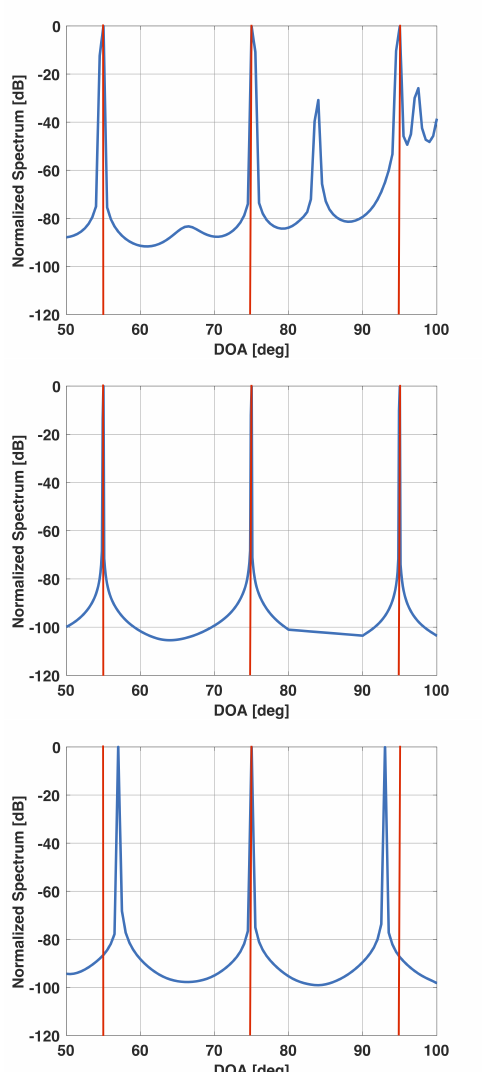
Figure 7. Solution vector x versus DOA for a uniform linear array of 15 elements in the presence of three signals at 55 ◦ , 75 ◦ , and 95 ◦ . For this scenario, β 0 = 0.0171. β = 0.02 ( top ), β = 0.0243 (selected beta) ( middle ), β = 0.1 ( bottom